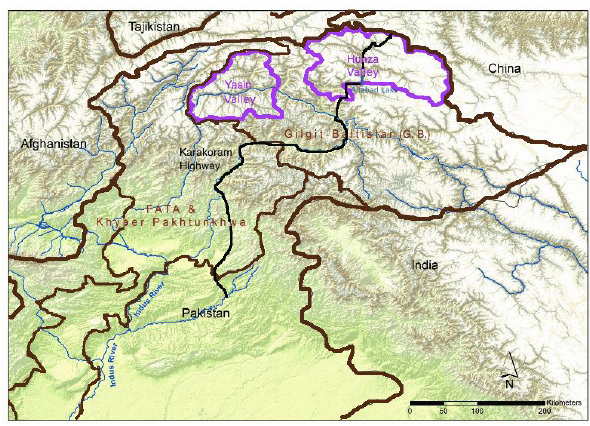
Figure 3. Location of the Pakistan research site. Source: Gioli et al. (2014) (Fig.